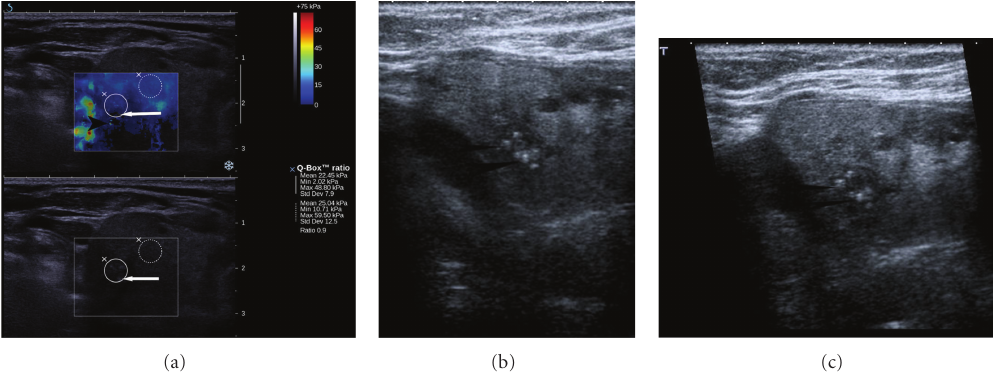
Figure 3: A colloid nodule in a patient with nodular goiter and papillary carcinoma. (a) on supersonic shear wave elastography (upper image) the colloid nodule (full circle) is very soft with punctuate increased sti ff ness (arrow head) representing microcalcifications (some not visible on B-mode lower image), in contrast to bigger high echogenicity foci (arrow), which are soft and represent inspissated colloid as evident on subsequent images. (b) presents comet tail artifacts (arrow heads) that change the direction with steering of ultrasound beam (c) indicating the nature of this artifact that is attributable to inspissated colloid in thyroid nodule.